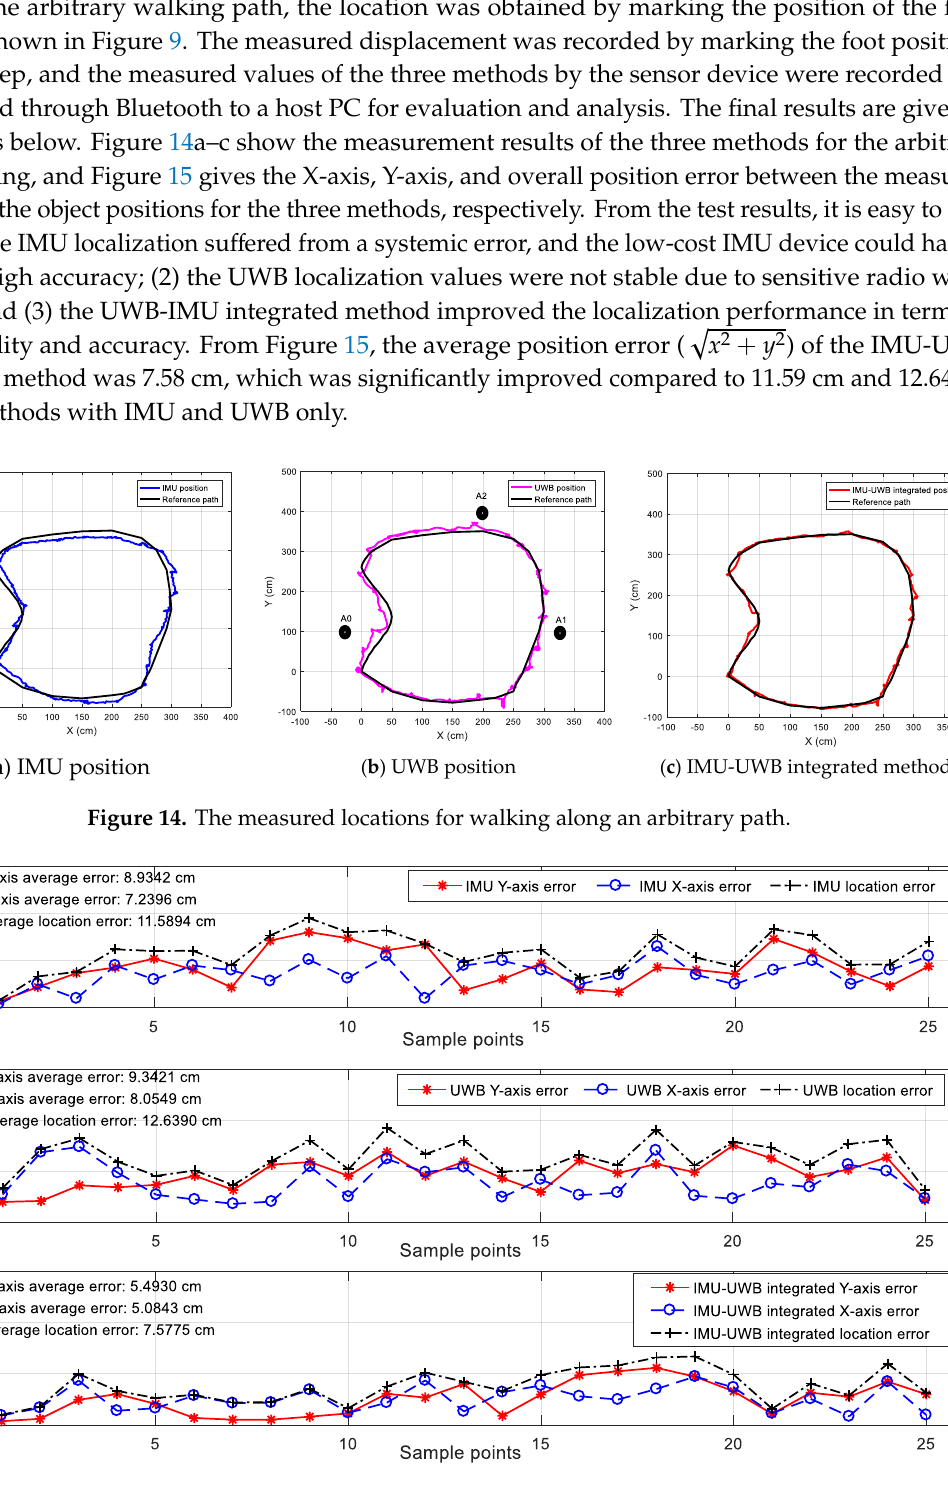
Figure 15. The measurement errors of the three methods.